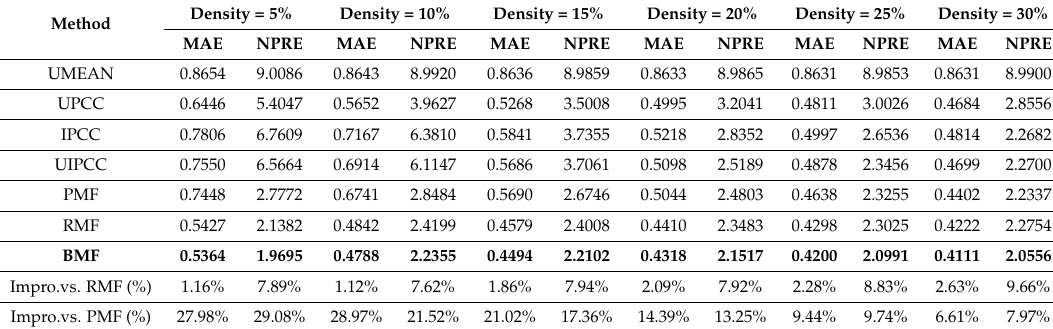
Table 3. Accuracy comparison of response time.